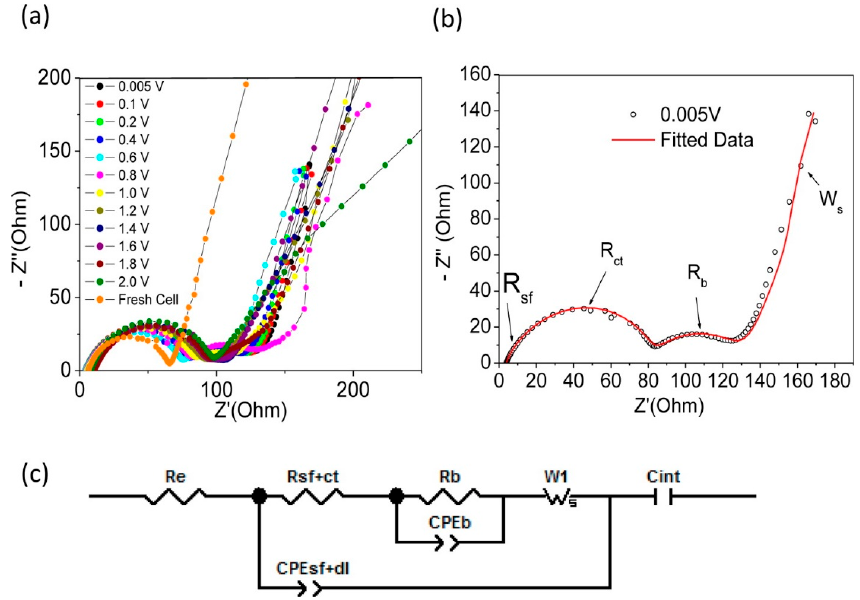
Figure 6. ( a ) EIS of InVO4 anode at different voltages; ( b ) EIS of InVO4 at 0.005 V and ( c ) the corresponding equivalent-circuit model. Adapted with permission from [23], © American Chemical Society,